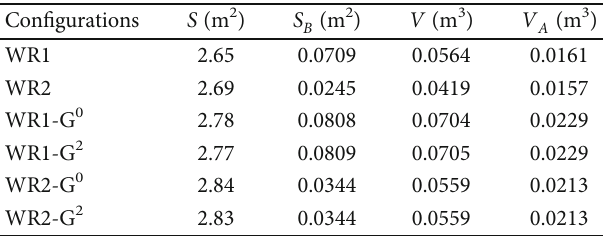
Table 4: Overall geometric characteristics of the blunted